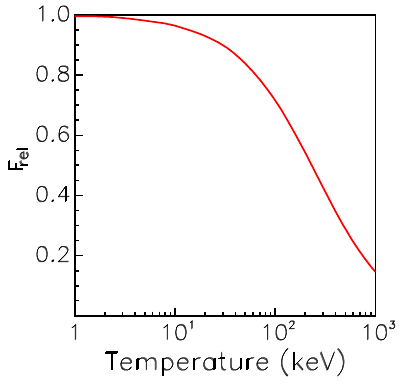
Figure 1. The relativistic factor F power loss (RPL)